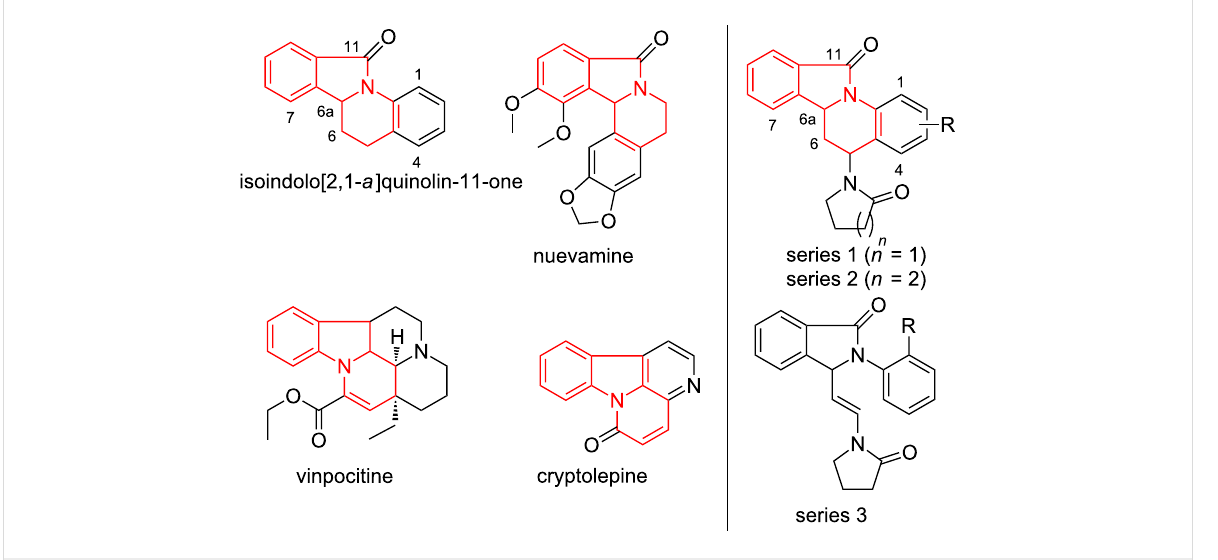
Figure 1: Pyridoisoindole frameworks (highlighted) in bioactive molecules and compounds under present investigation (series 1–3 ).